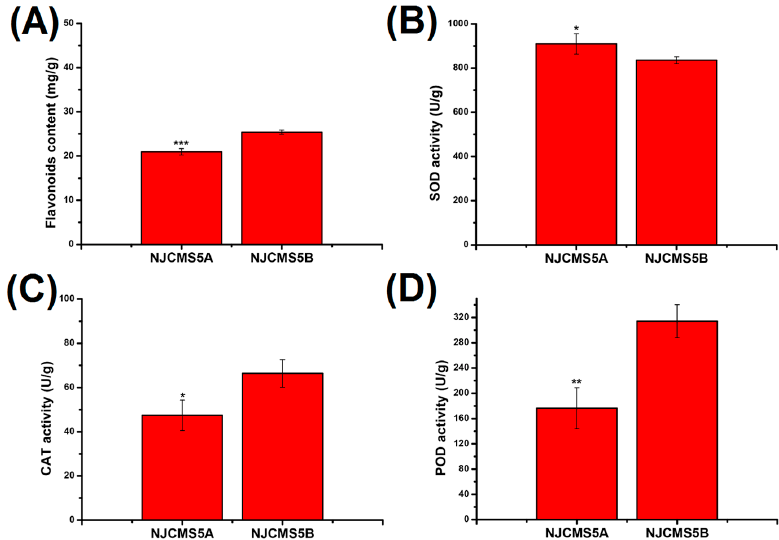
Figure 6. Changes of flavonoid content and antioxidant enzyme activities in flower buds of NJCMS5A and NJCMS5B. ( A ) Flavonoids; ( B ) SOD–Super oxide dimutase; ( C ) CAT–Catalase; ( D ) POD–Peroxidase. Asterisk indicates statistical differences, * p < 0.05; ** p < 0.01; *** p < 0.001.